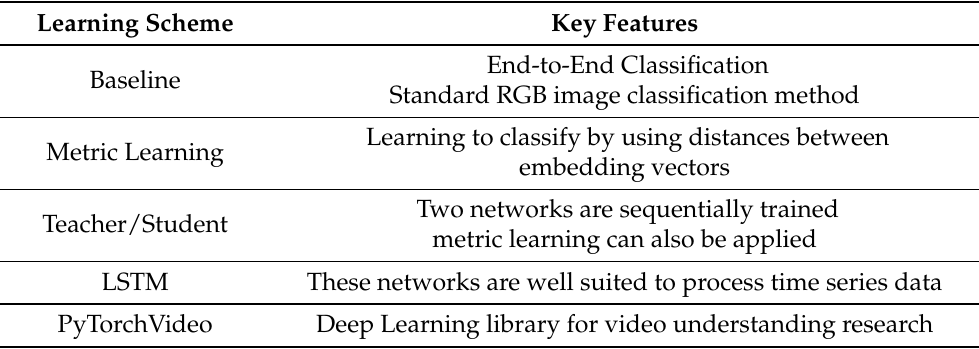
Table 2. Overall scheme of training